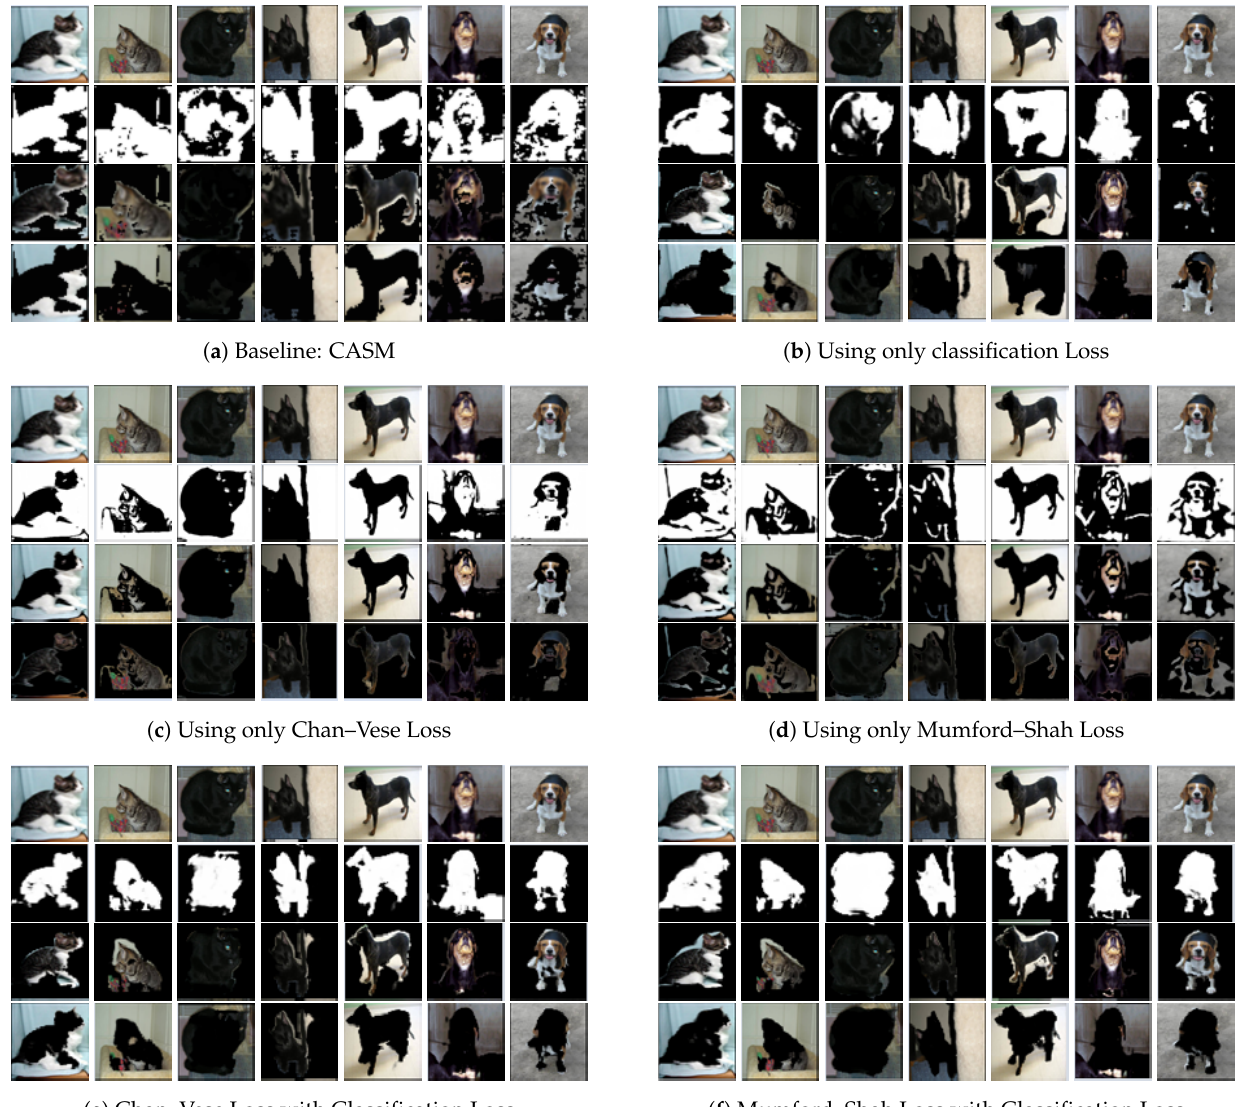
Figure 4. The original input images (i.e., I ) are in the first row. The second row shows the masks (i.e., 1 − φ ) . The foreground (i.e., ( 1 − φ ) · I ) images are in the third row, and the background (i.e., φ · I ) images are in the last row. The result images are randomly selected form the validation